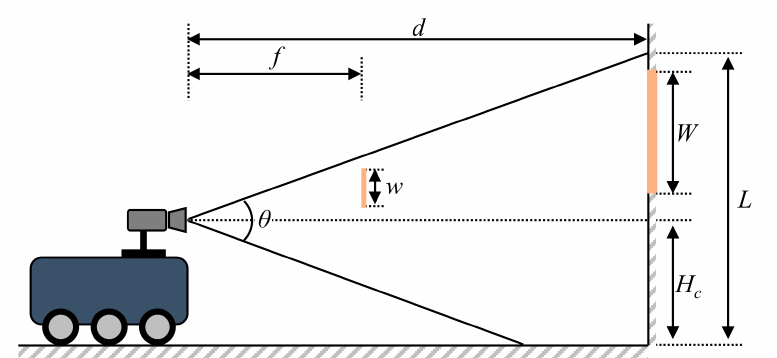
Figure 8. Relationship between the camera, the marker, and the marker image. These values are determined based on the specifications of the